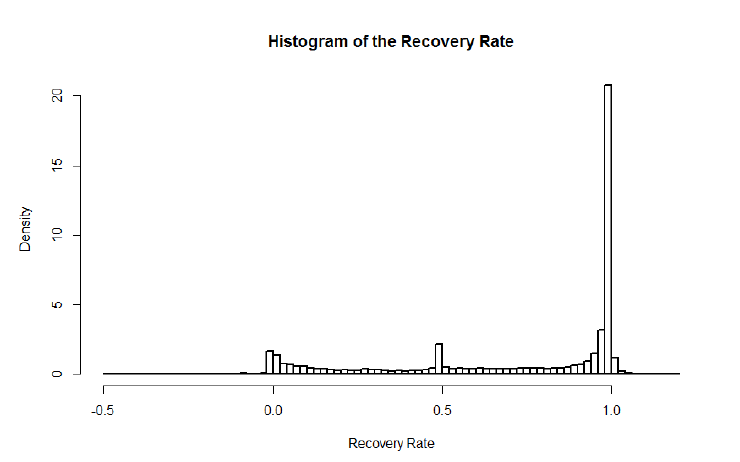
Figure 3. Histogram of the recovery rate in our data (small- and medium-sized entities (SME), US-based).